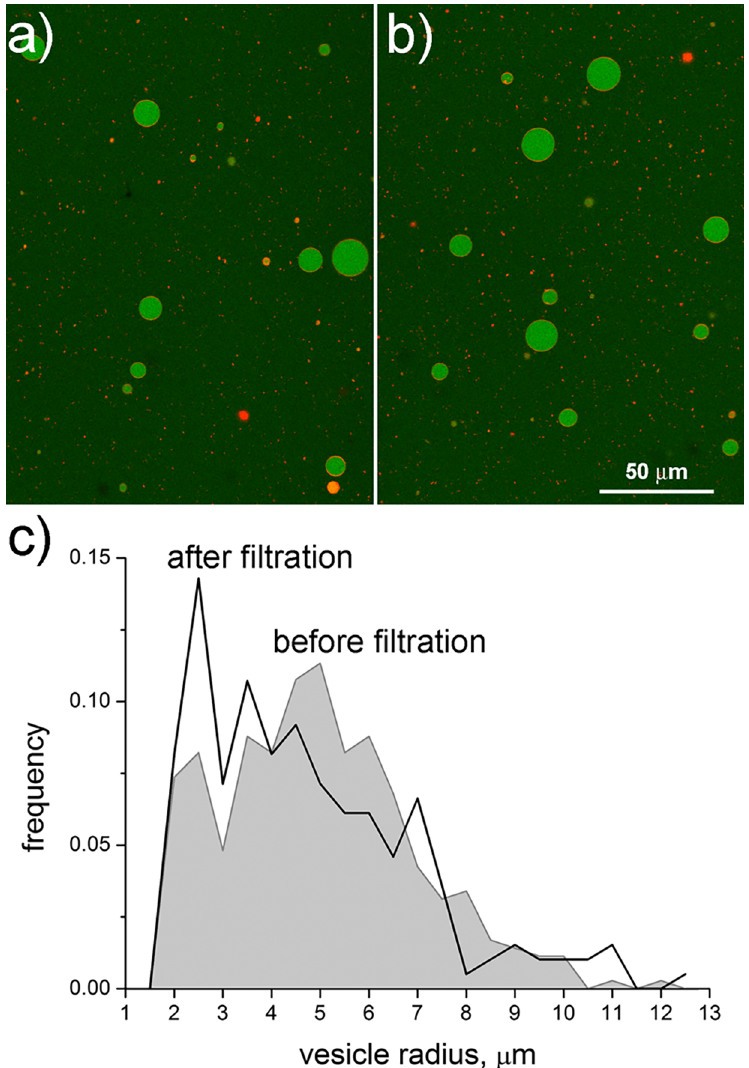
Fig 4. Giant vesicles before and after filtration. GVs prepared by the natural swelling of a mixture of oleic acid, monooleoyl glycerol, dioleoyl glycerol, DOPA (4:1:2:3 molar ratio). Calcein (5 μ M) was encapsulated inside the vesicles, while their membrane was stained (by co-hydration) with 0.1 mol% of DOPE-Rh. (a) Raw GVs obtained from film hydration and subsequent dilution with O-solution. (b) Appearance of the retentate after filtration ( b = 3, Δ P = 400, β = 10). (c) GV size distribution of the two GV populations (before filtration: grey area; retentate: black line). Statistical analysis detailed in the